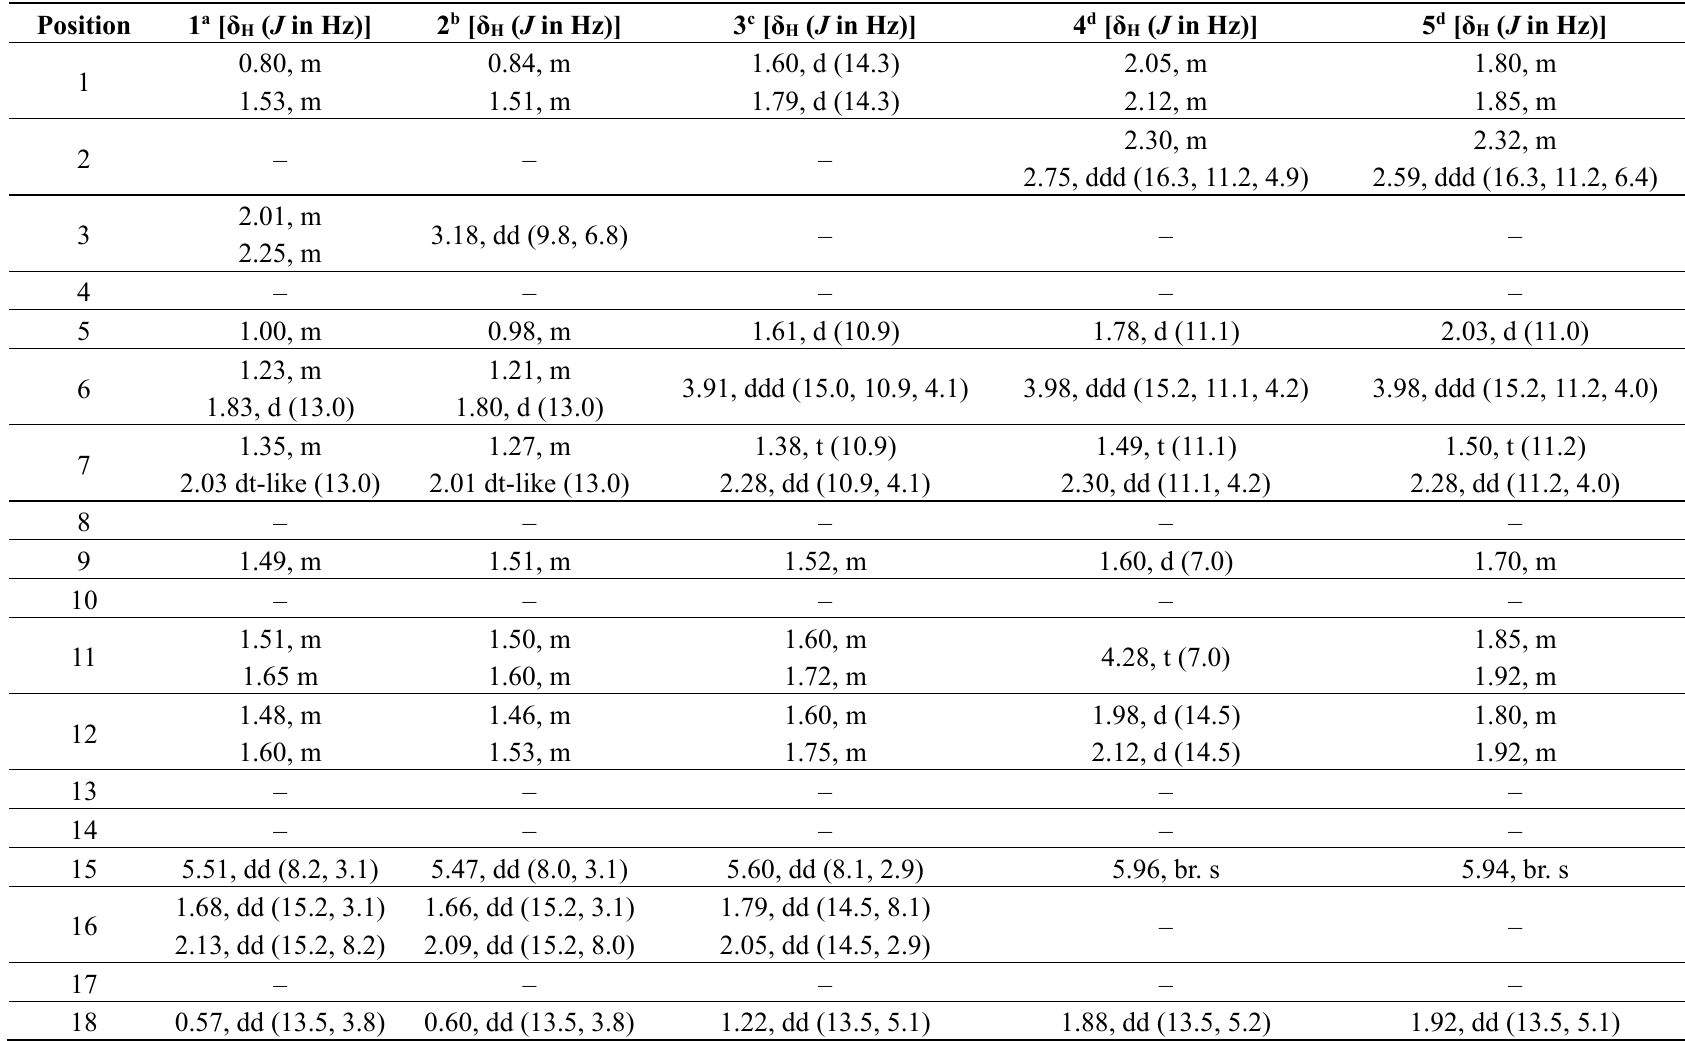
Table 2. 1 H-NMR Data of compounds 1 – 5